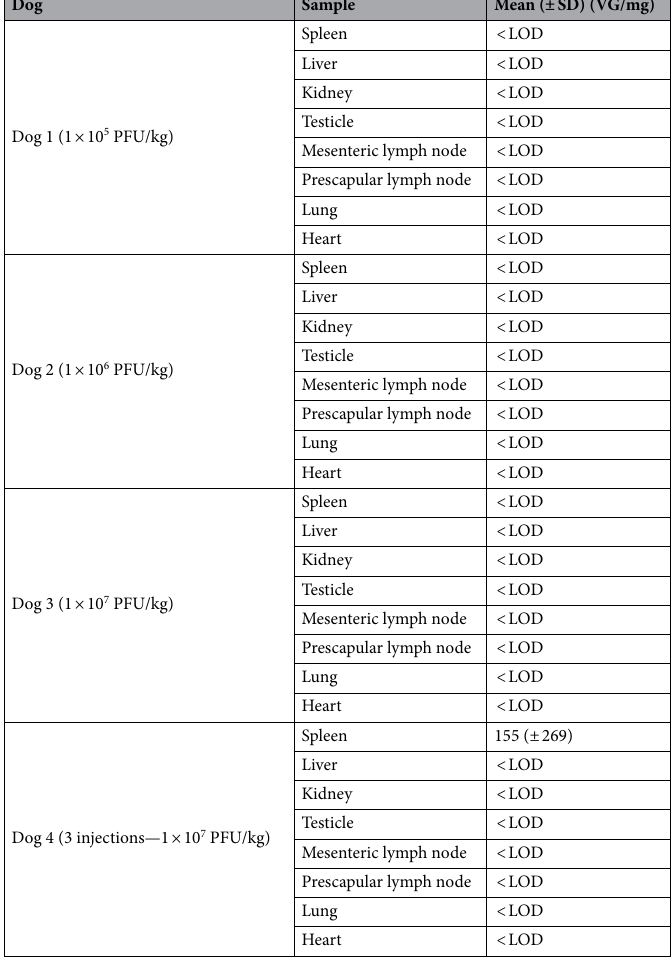
Table 3. Detection of vaccinia virus DNA in organs by q-PCR assay after single and multiple intravenous injection of TG6002. All samples were measured in triplicate. LOD limit of detection, SD standard deviation, VG viral